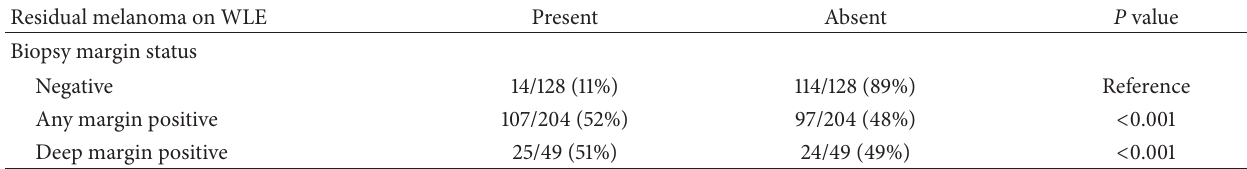
Table 4: Frequency of residual melanoma on wide local excision by biopsy margin